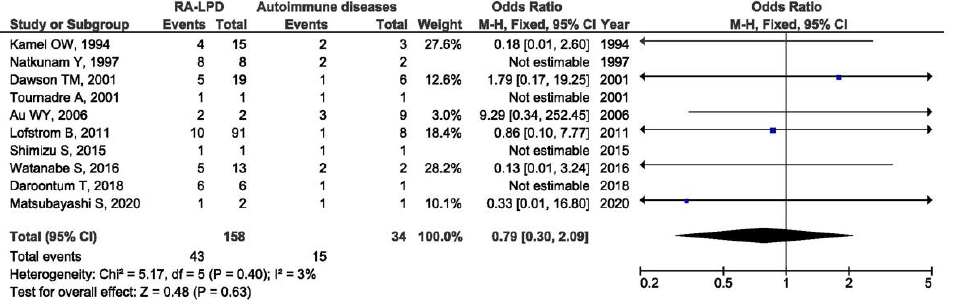
Figure 5. Meta-analysis of the difference in the positive EBV result in RA-LPD patients and patients with autoimmune diseases other than RA and LPD (blue dot represent the odds ratio and black frame 95% CI of the odds ratio from each of the included studies. black arrows show that upper and/or lower limit of the 95%CI of odds ratio is below or above defined values on the x axis).